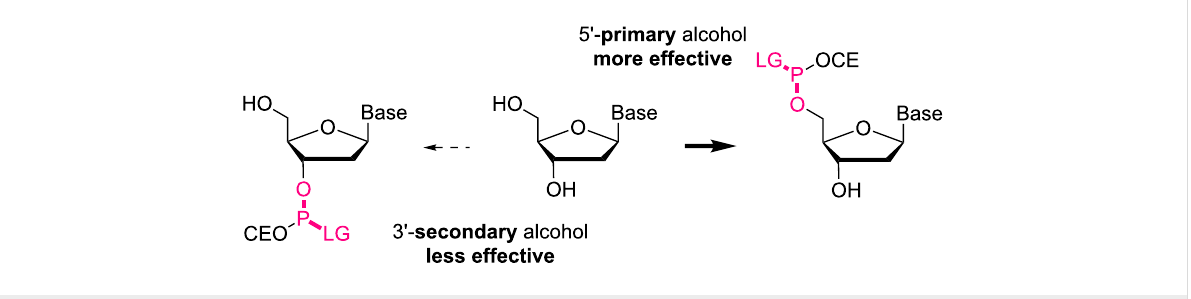
Figure 2: Expected reactivity of 5’- and 3’-terminus for the activation.